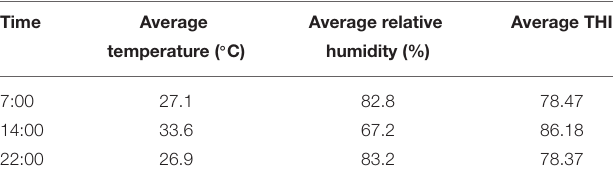
TABLE 2 | Average temperature and humidity and average temperature and humidity index of the barn during the official test period (50